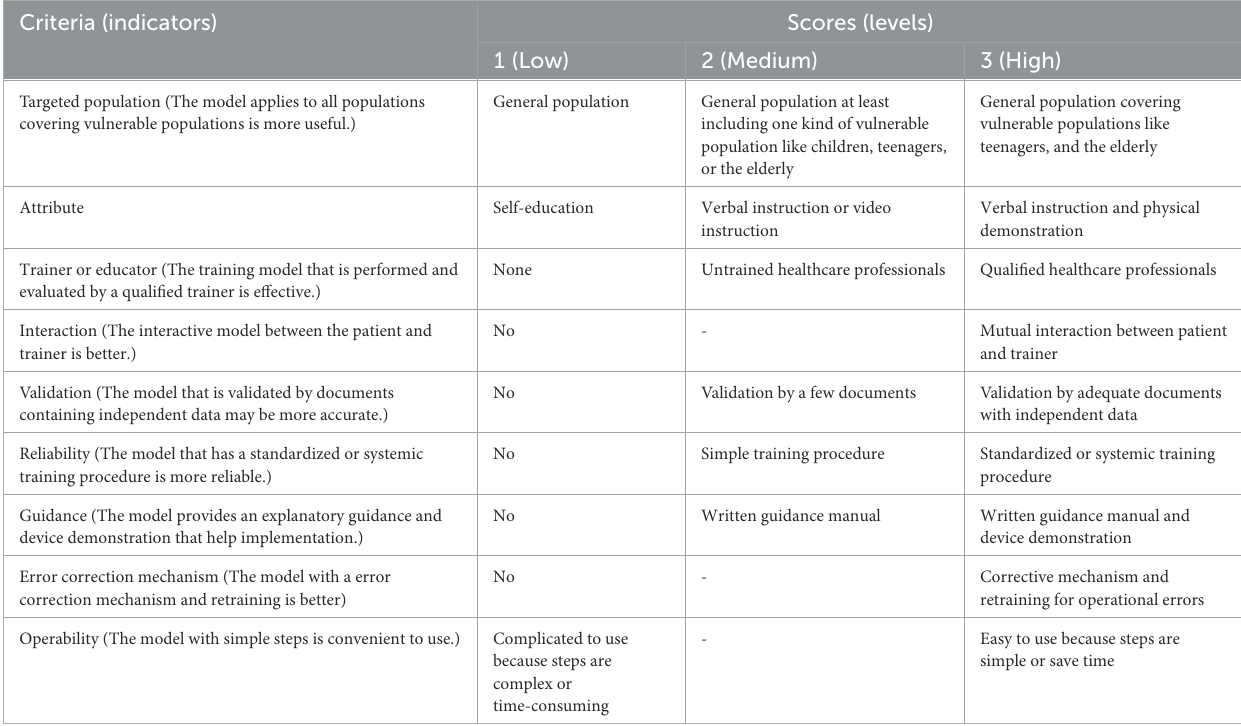
TABLE 2 Scoring system used for the multi-criteria analysis for training models. Criteria